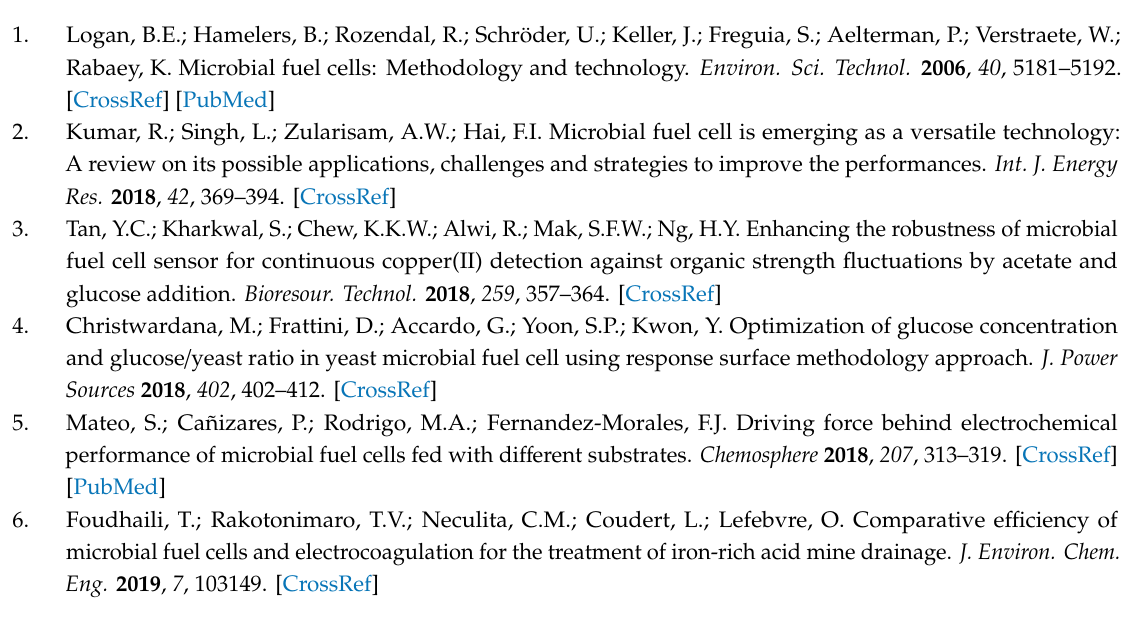
Figure S1: Design of a dual-chamber MFC reactor, Figure S2: Rarefaction curves obtained for biomass samples collected from MFC1 and MFC2 during the experiment (in Sample_ID the name of MFC and the day of sampling are